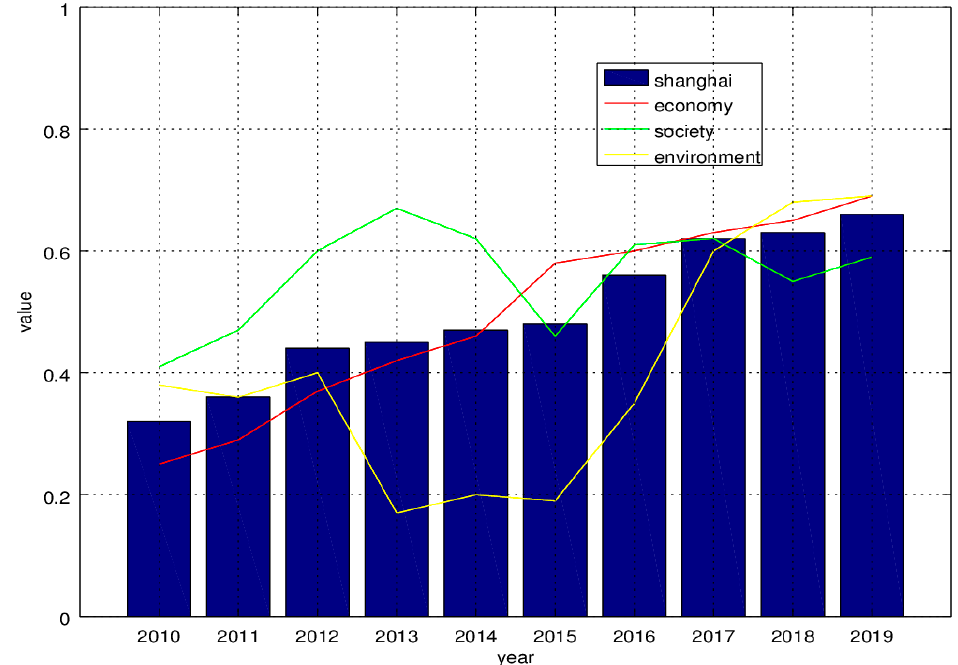
Figure 3. Urban vitality comprehensive index of Shanghai from 2010 to 2019.